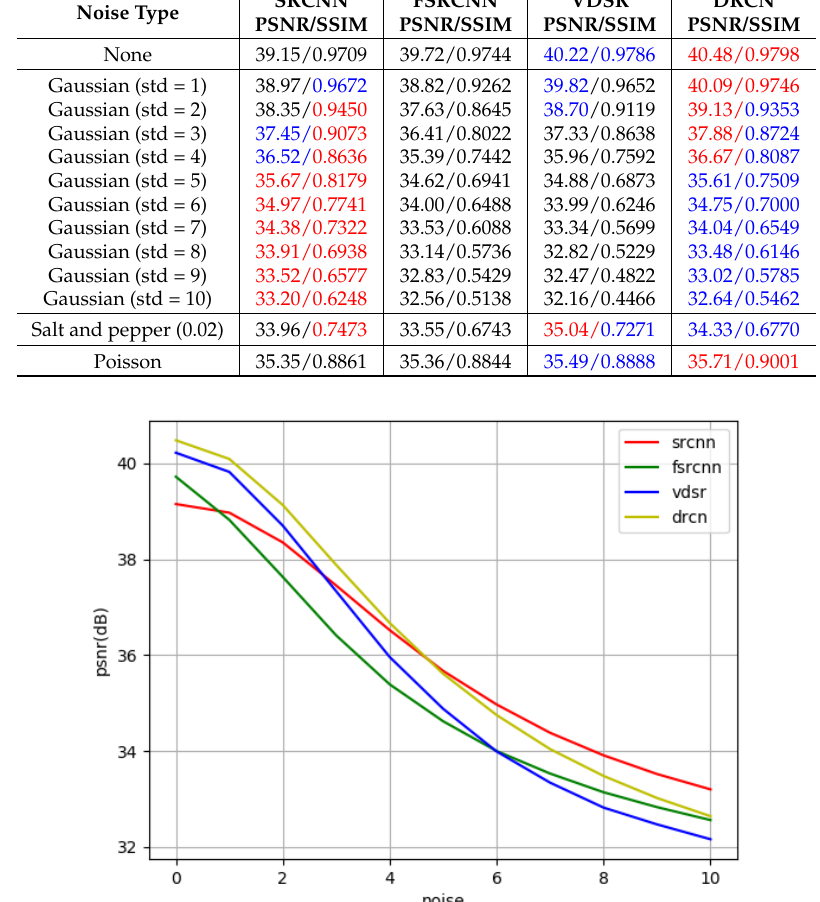
Figure 9. PSNR curve with different std of Gaussian